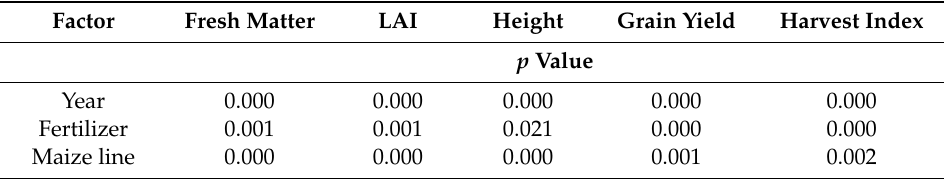
Table 5. Analyses of variance for effect of year, fertilizer, and maize line on fresh matter, leaf area index, plant height, grain yield, and harvest index.